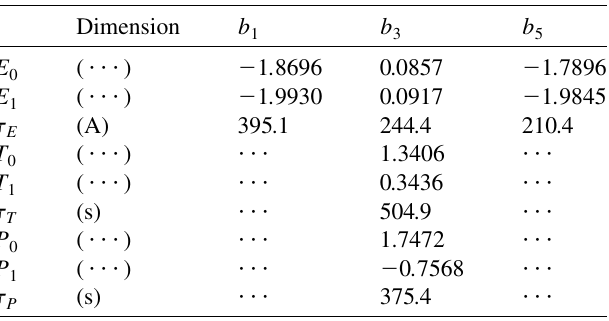
TABLE V. Parameters obtained fitting the model of Eq. (16) to decay measured as a function of flattop current, flattop the b 3 time, and preinjection time variations from the magnet popula- tion analyzed.